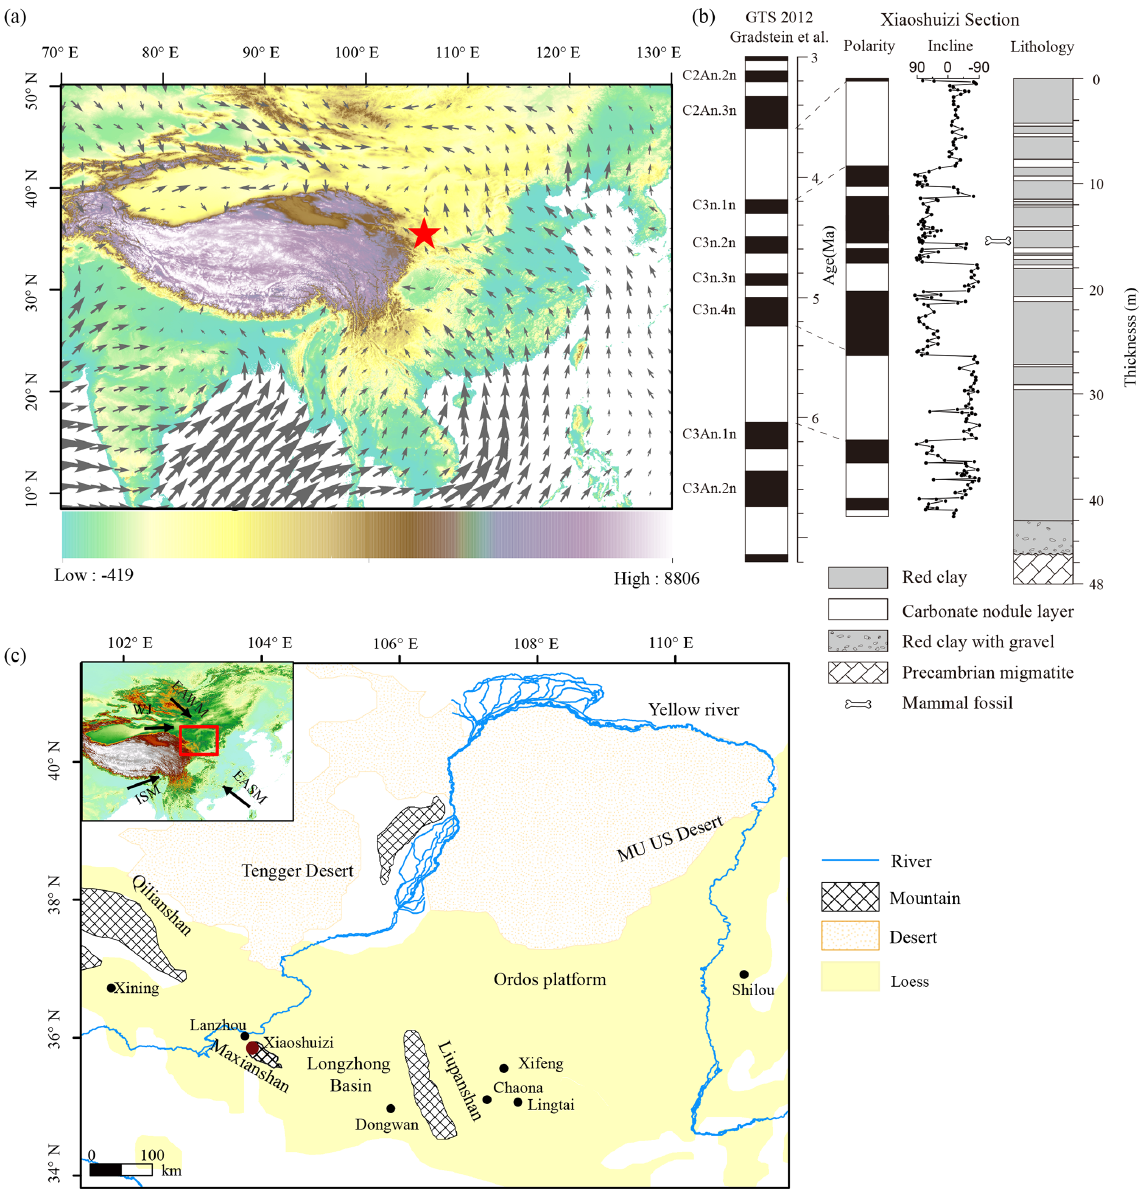
Figure 1. Location of the study area and atmospheric circulation patterns. (a) 850hPa vector wind averaged from June to August for 1982– 2012 based on NOAA Earth System Research Laboratory reanalysis data (https://www.esrl.noaa.gov/psd/, last access date: 20 August 2018). (b) Lithology and magnetostratigraphy of the XSZ drill core. (c) The Chinese Loess Plateau with locations of the studied Xiaoshuizi site and other sections mentioned in the